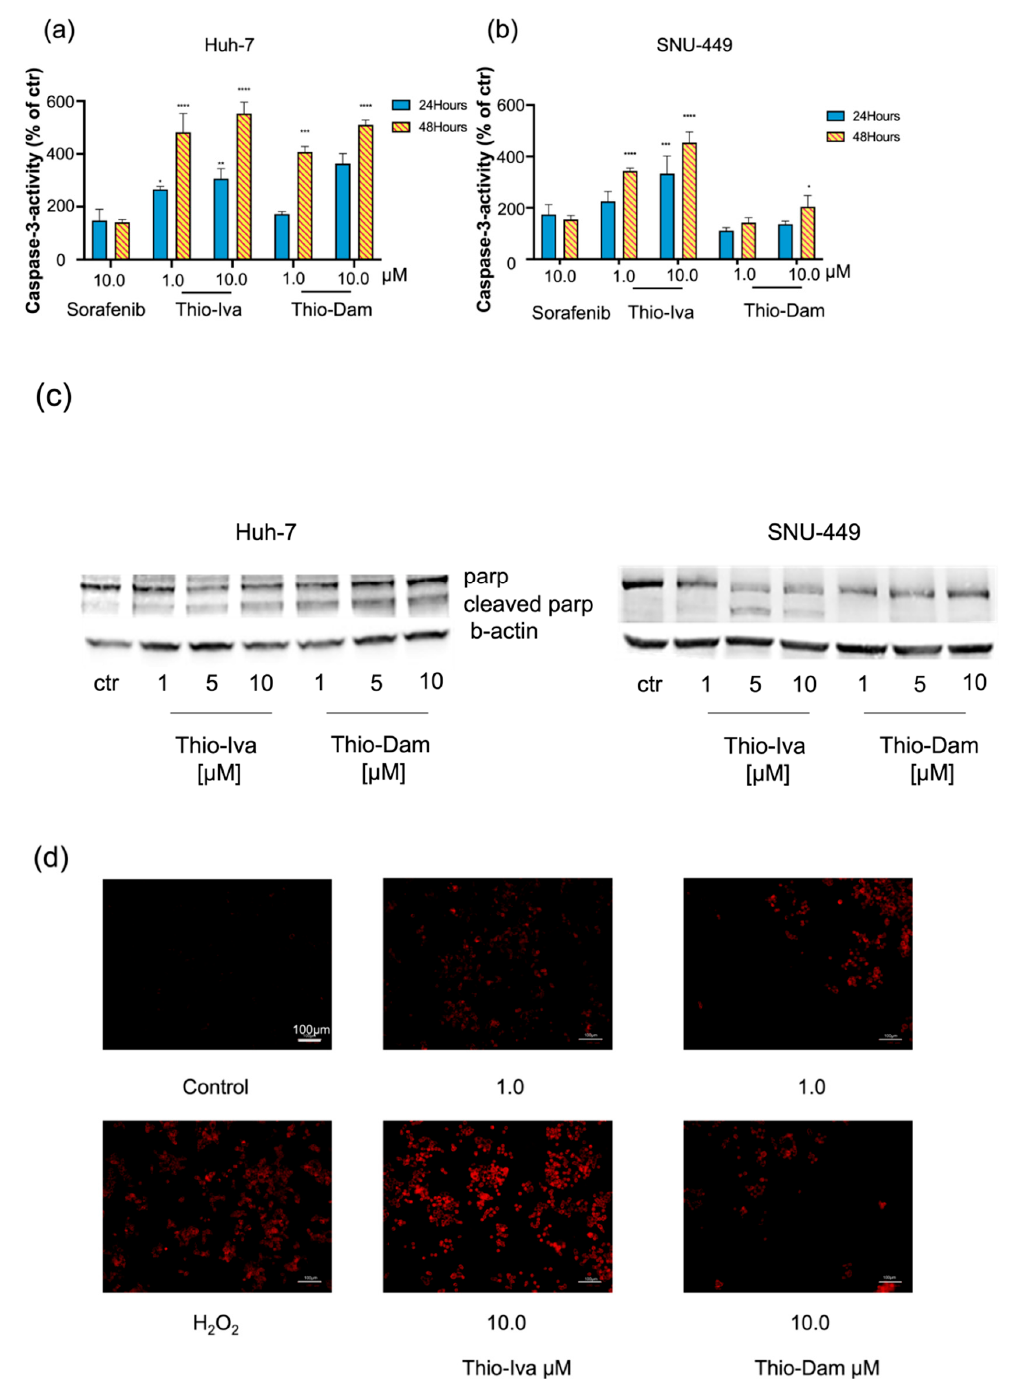
Figure 6. Induction of Apoptosis. ( a ) Dose- and time-dependent caspase-3 induction in Huh-7 cells after treatment with 1 and 10 µ M of Thio-Iva and Thio-Dam and 10 µ M sorafenib for 24 h and 48 h. ( b ) Dose- and time-dependent caspase-3 induction in SNU-449 cells after treatment with 1 and 10 µ M of Thio-Iva and Thio-Dam and 10 µ M sorafenib for 24 h and 48 h. Results are given as means ± SEM of n = 3 independent experiments. * p < 0.05, ** p < 0.01, *** p < 0.001, and **** p < 0.0001 by ordinary one-way ANOVA compared to untreated controls. ( c ) Representative Western blot results out of n = 3 independent experiments, showing PARP and cleaved PARP expression change by treatment, induced in Huh-7 and SNU-449 cells after 48 h. β -actin was used as loading control. ( d ) Detection of ROS induction by Thio-Iva and Thio-Dam in HCC cells after 24 h. H 2 O 2 served as a positive control. Scale bar, 100 µ